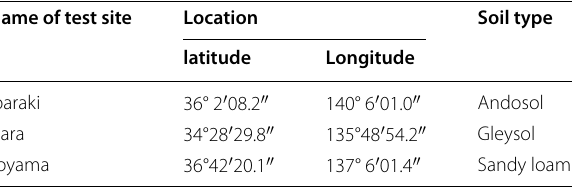
Table 1 Characteristics of the three field test sites Name of test site